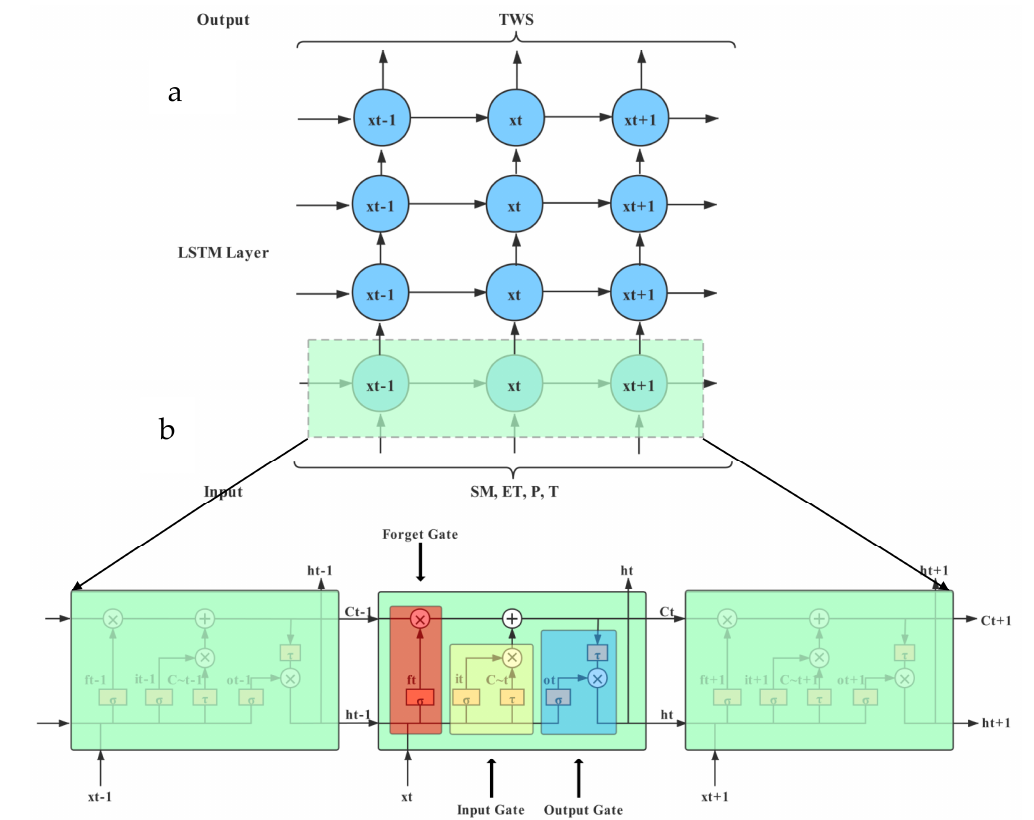
Figure 2. ( a ) Chain-like structure of the Long Short-Term Memory (LSTM). ( b ) A graphical representation of LSTM’s memory block.